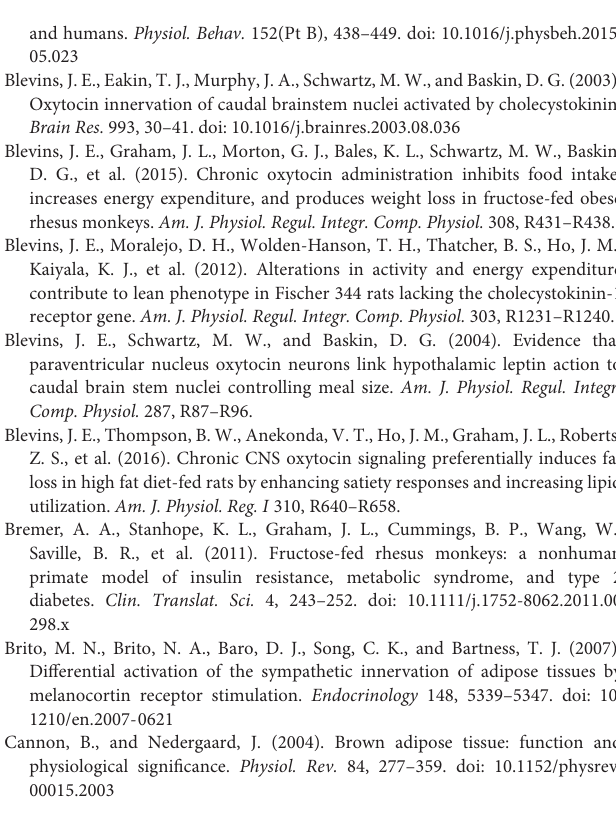
Supplementary Figure 1 | Study paradigms. (A) Study 1, (B) Study 2, and (C) Study 3. Supplementary Figure 2 | Negative controls for UCP-1 staining in IWAT, EWAT, and IBAT. Images were taken from fixed (4% PFA) paraffin embedded